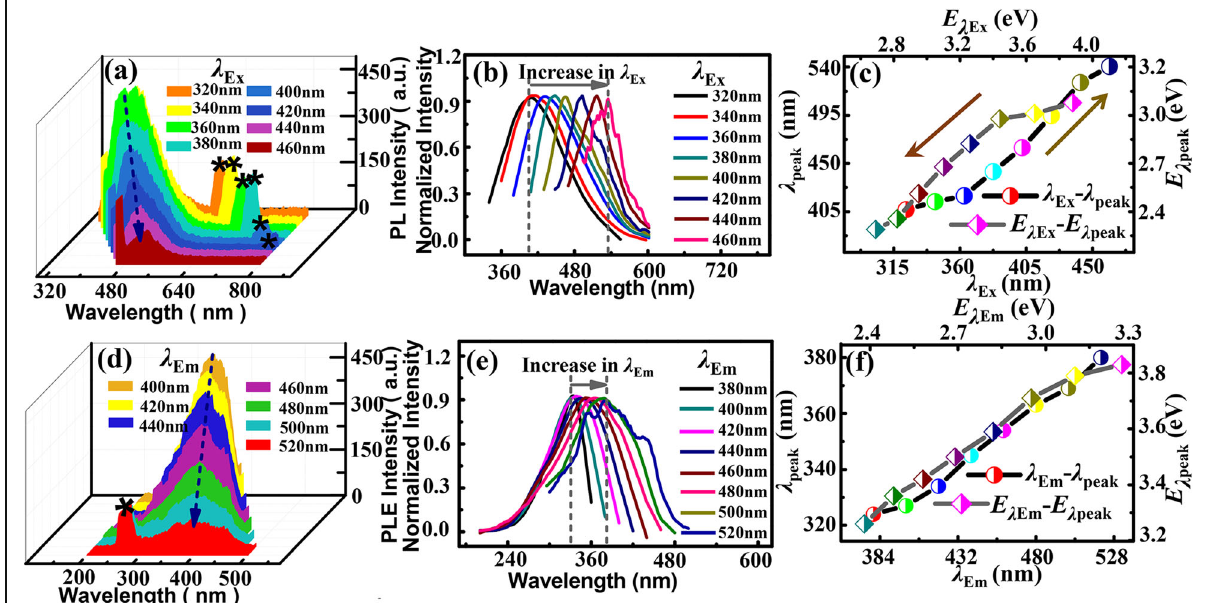
Fig. 3 a , d The PL & PLE spectra of TaS 2 QDs [* interference peak ( λ Ex and λ Em ) from the instrument], respectively; b , e The PL and PLE normalized spectra of TaS 2 QDs under different λ Ex and λ Em , respectively; c , f the relationship of peak and energy for TaS 2